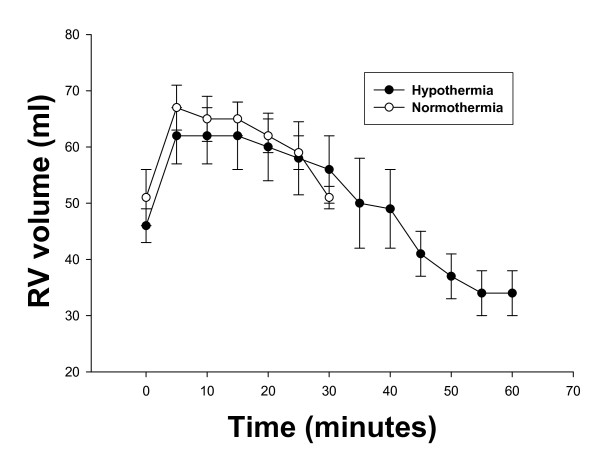
The time course of mean right ventricular (RV) volumes (mean ± SEM) during untreated ventricular fibrillation (VF) in both normothermia and hypothermia swine. Note that the right ventricle never approaches 2/3 of baseline value - never achieves stone heart.